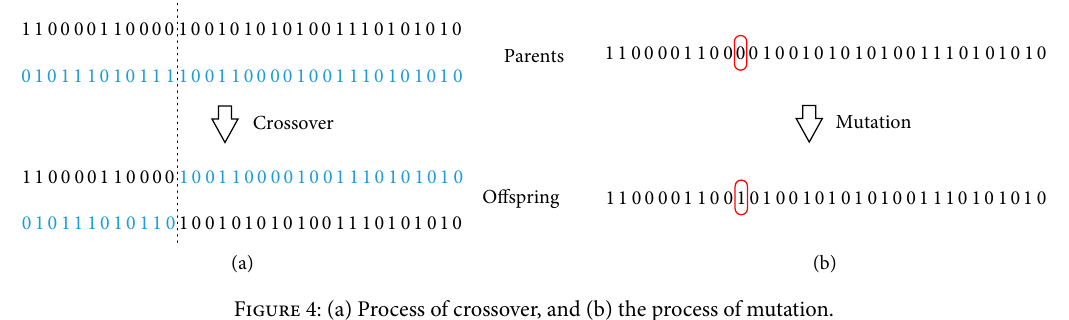
Figure 4: (a) Process of crossover, and (b) the process of mutation.